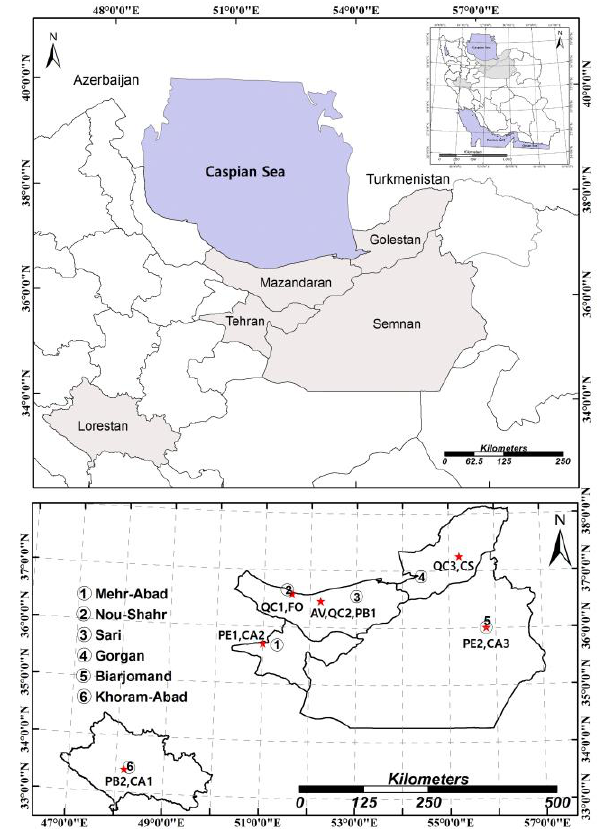
Figure 1. Locations of the measurement sites